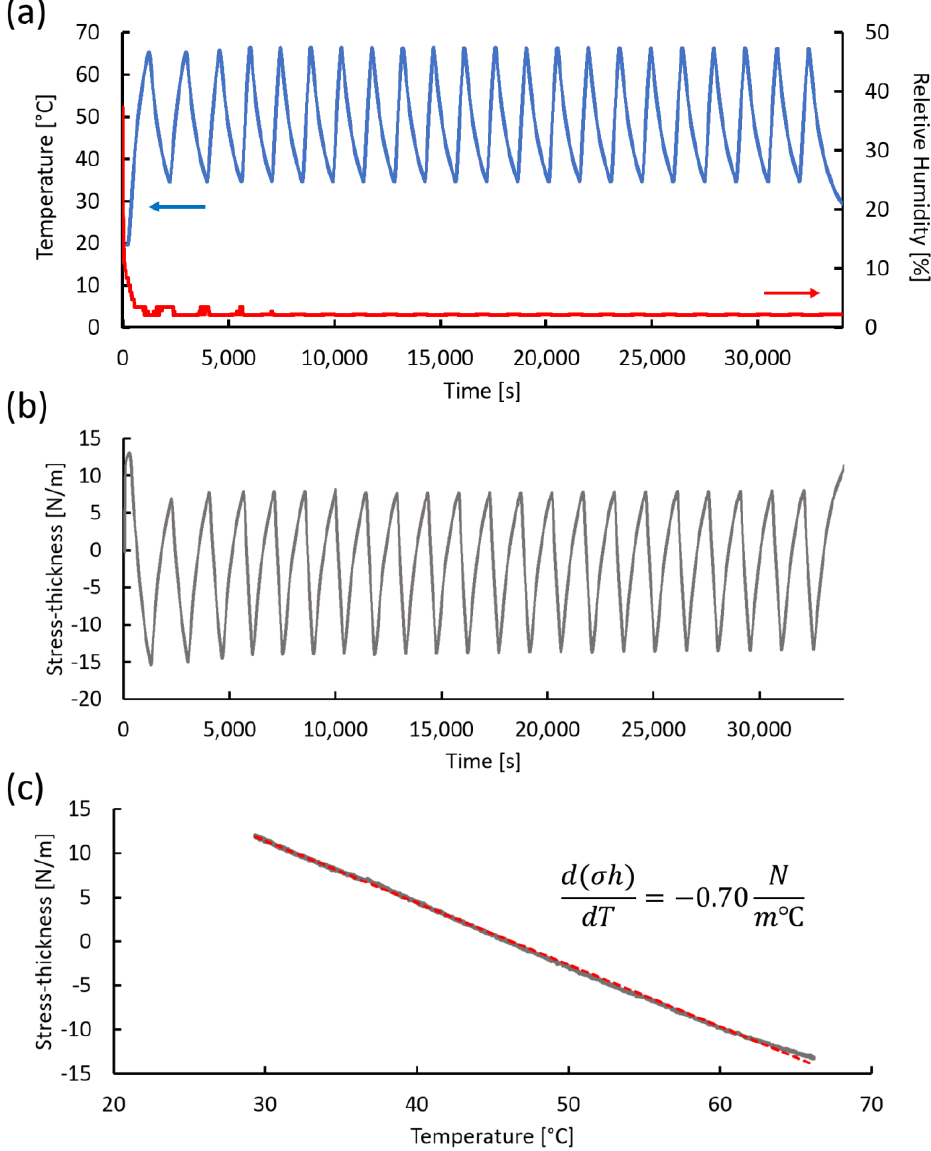
Figure 9. Thermal stress measurement using in situ cantilever curvature. ( a ) Change in temperature (blue) and relative humidity (red) during a typical thermal cycling experiment. ( b ) Stress-thickness response during 22 thermal cycles. ( c ) A plot of stress-thickness vs. temperature during the final cooling cycle. The red dotted line represents a linear regression line with a slope of − 0.70 N/(m°C).